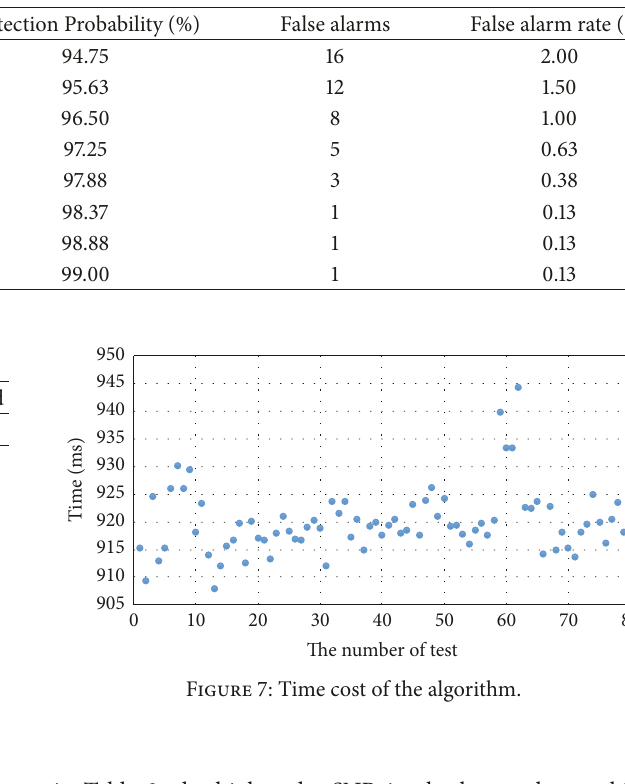
Table 2: Detection probability and false-alarm rate of the masking technique.